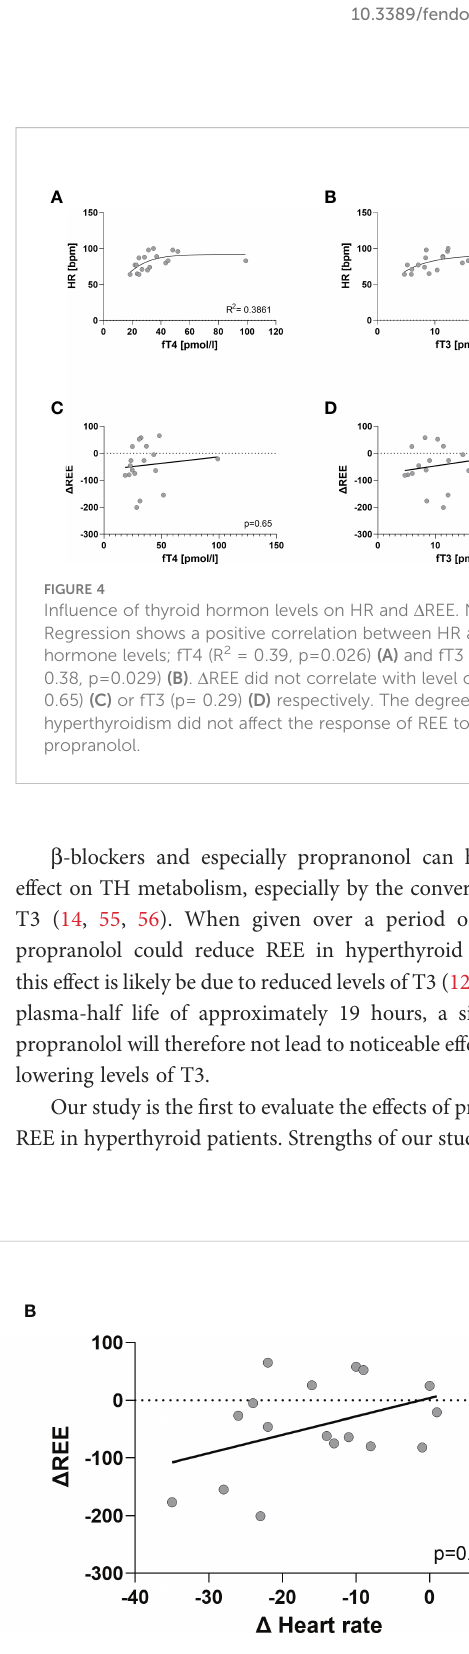
FIGURE 3 Pulse rate was measured before interventional visit and monitored every 30 minutes after administration of propranolol. Pulse reate decreased signi fi cantly (p<0.0001) from 81 ± 12 bpm (baseline) to 67 ± 7.6 bpm (after propranolol) (A) . The correlation between the change in heart rate ( D HR) and the change in REE ( D REE) was r=0.41, R 2 = 0.17 and p=0.10 (B) .